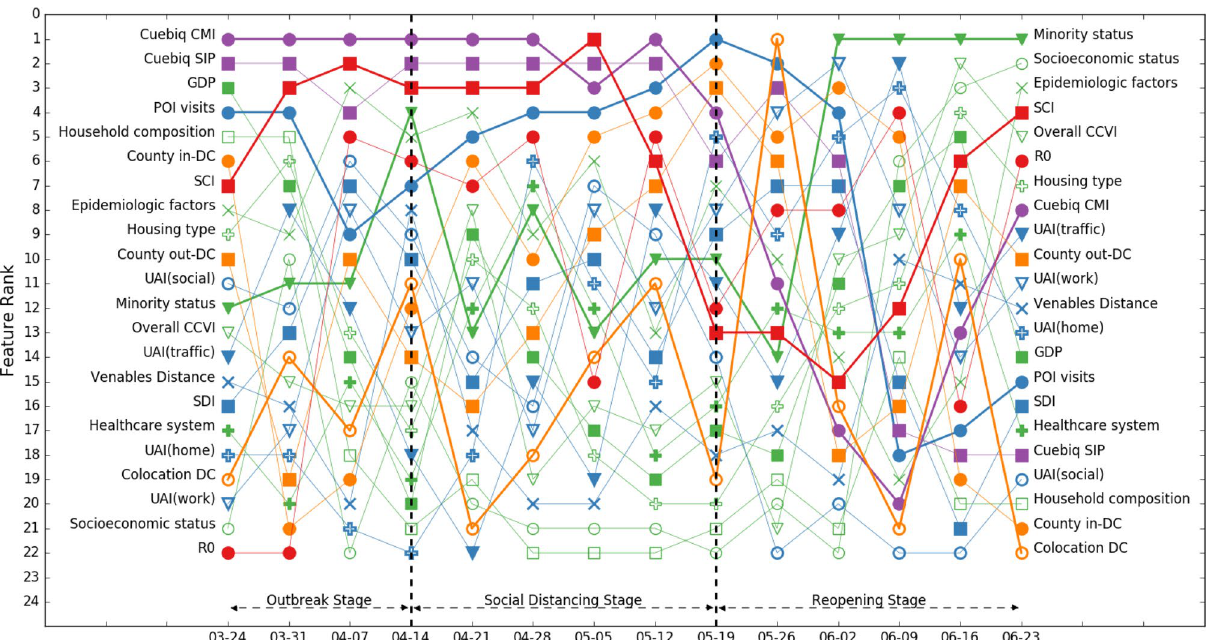
Figure 5. Rank of feature importance of model 3 throughout three stages of COVID-19. Mobility and social network structure features show high importance in counties with high population